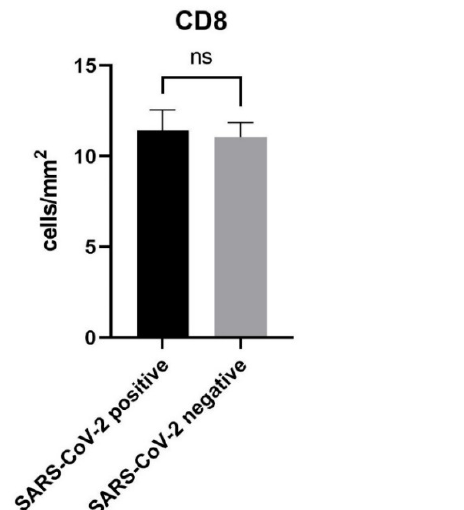
Figure 3. Table and graph relating to the density of CD8+ lymphocytes in the samples of the two groups of studies. Note that, also in this case, there was no statistically significant difference ( p value: 0.4932, >0.05). ns notes not significant. HMGB1 expression was 3.304 ± 0.2977 (cells/mm 2 ) in the SARS-CoV-2 positive patients group and 2.448 ± 0.2472 (cells/mm 2 ) in the SARS-CoV-2 negative patients group. The difference was statistically significant ( p value: <0.0001). (Figures 4 and